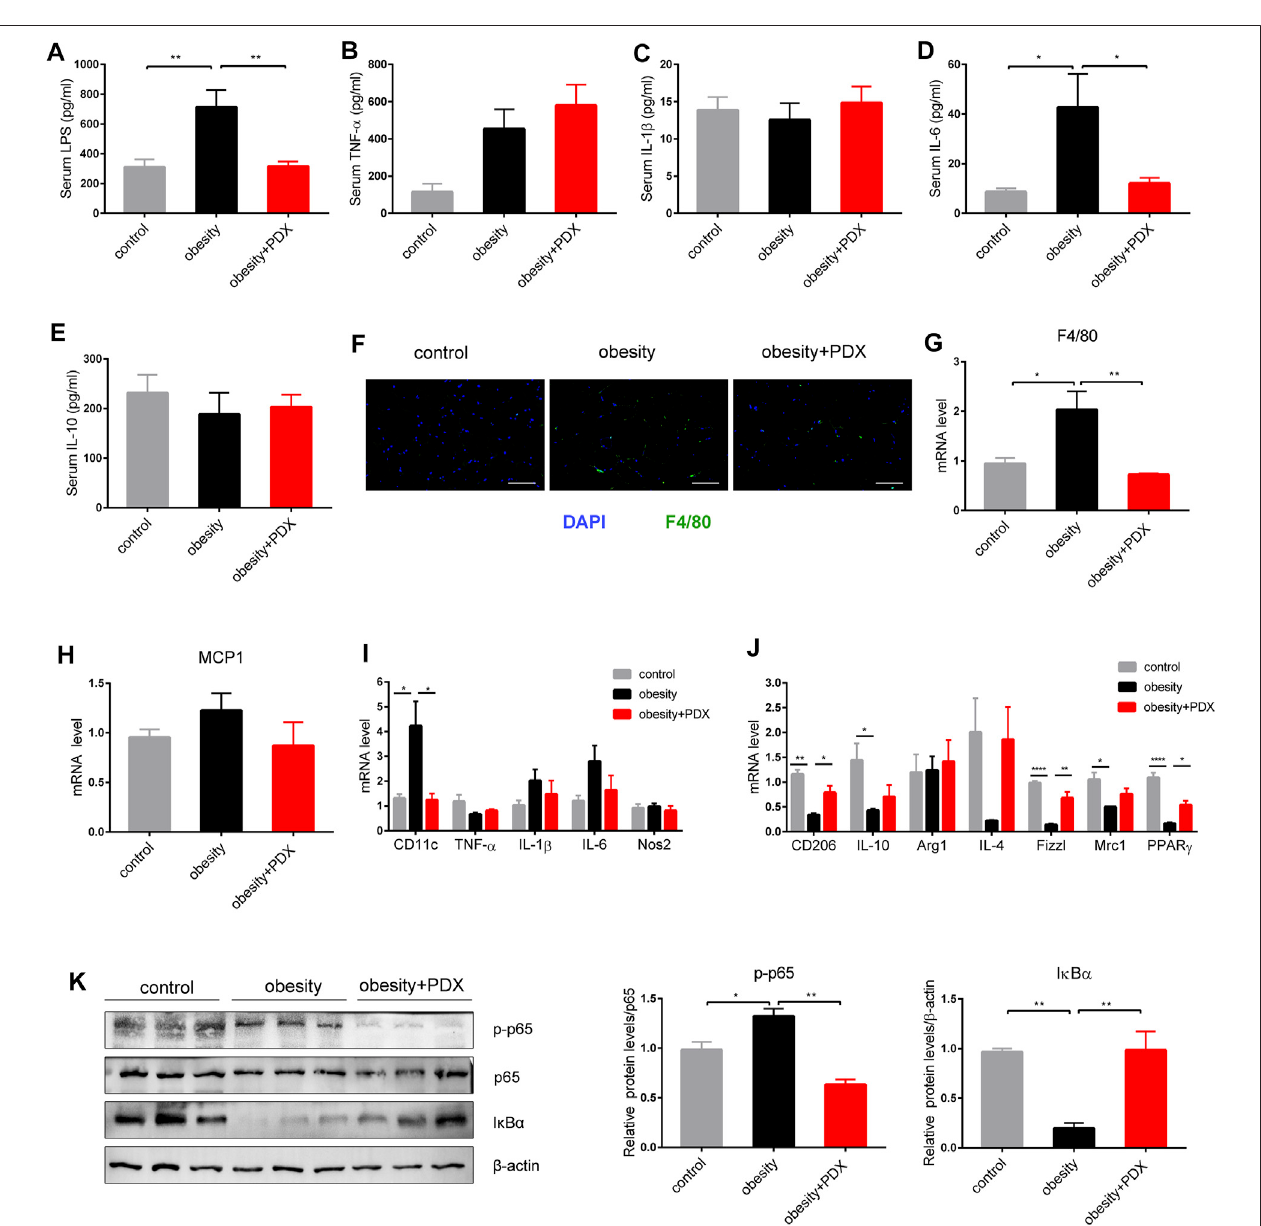
FIGURE 7 | PDX alleviated in fl ammation levels and promoted macrophage polarization toward M2 phenotype in the epididymal adipose tissue of HFD-induced obese mice(Part 2). (A) Serum LPS. (B) Serum TNF- α (B) . (C) Serum IL-1 β . (D) Serum IL-6. (E) Serum IL-10. (F) Representativeimages ofimmuno fl uorescencestainof epididymal adipose tissue against the speci fi c macrophage maker F4/80. Scale bar, 100 μ m; magni fi cation, x200. (G) qPCR analysis of the mRNA levels of F4/80 in epididymal adipose tissue. (H) qPCR analysis of the mRNA levels of MCP1 in epididymal adipose tissue. (I) qPCR analysis of the mRNA levels of M1 macrophage maker CD11c, TNF- α , IL-1 β , IL-6 and Nos2 in epididymal adipose tissue. (J) qPCR analysis of the mRNA levels of M2 macrophage maker CD206, IL-10, Arg1, IL-4, Fizz1, Mrc1 and PPAR γ in epididymal adipose tissue. (K) Western blot analysis of the proteins expression involved in NF- κ B signaling pathway in epididymal adipose tissue. n (cid:2) 10 (A – F) , n (cid:2) 4 (G – J) or n (cid:2) 3 (K) per group. * p < 0.05; ** p < 0.01; *** p < 0.001; **** p <